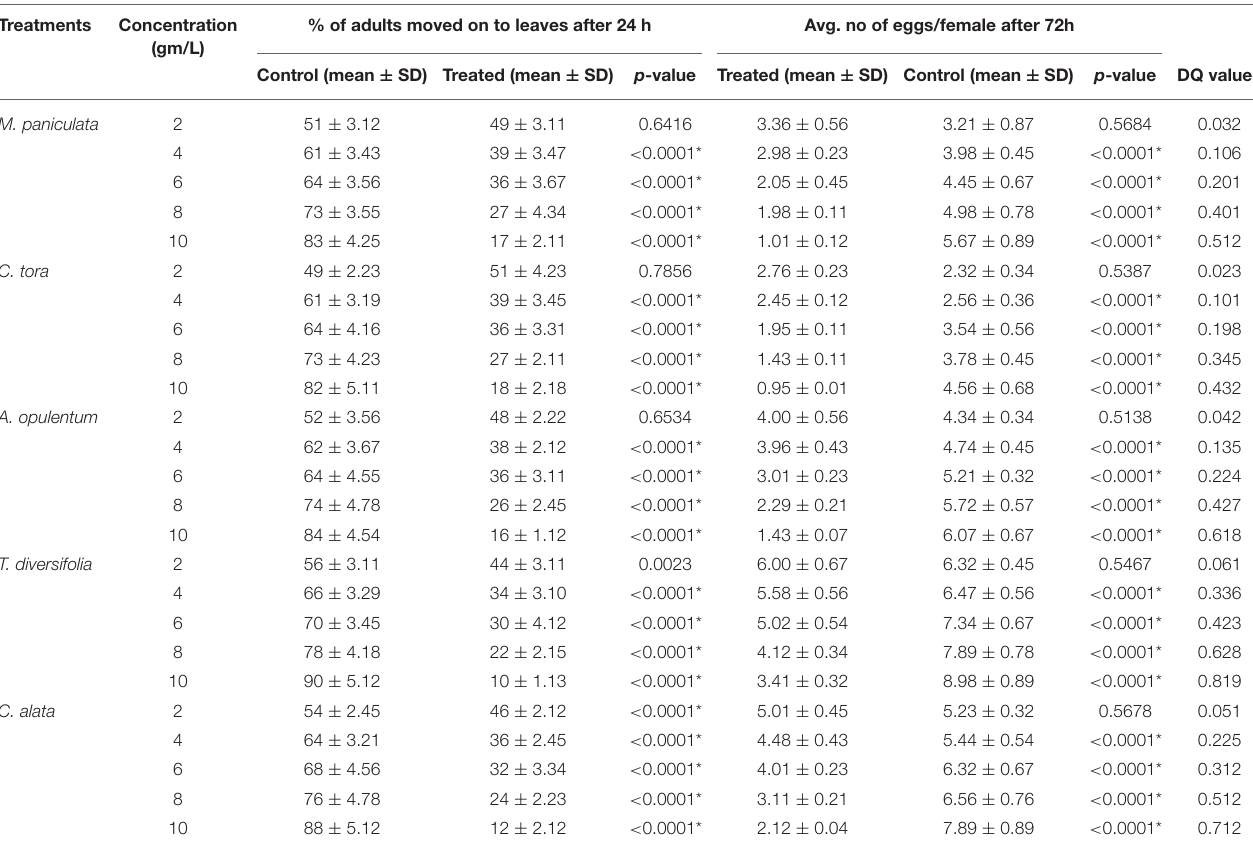
TABLE 3 | The percentage of female red spider mites that remained on the leaves where introduced and the numbers of eggs oviposited on the control (untreated) or treated tea leaves with pesticidal plant extracts in choice tests. Treatments Concentration